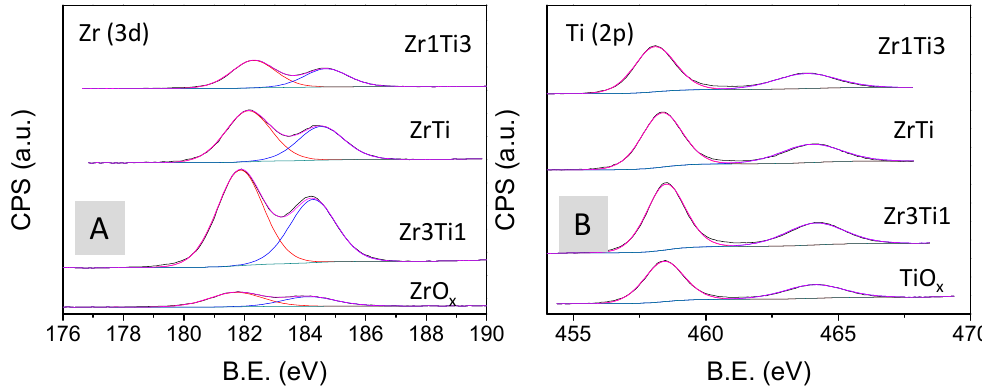
Figure 6. XPS profiles of Zr(3d) ( A ) and Ti (2p) ( B ) in Zr–Ti solids.